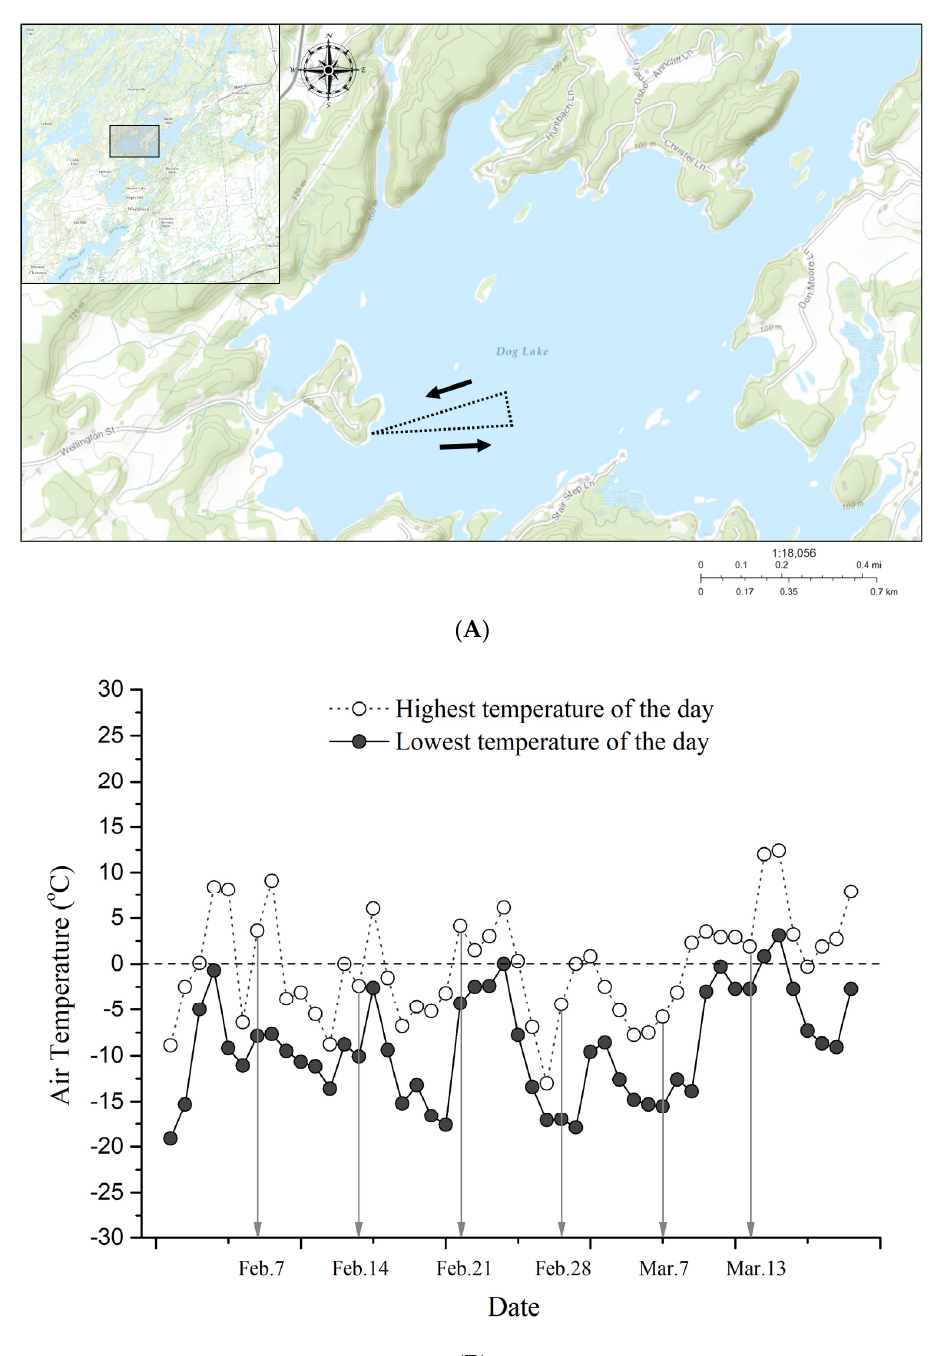
Figure 2. Site sampling information. ( A ) Site map of Gilmour Point, Dog Lake, South Frontenac County, Ontario (44.435635° N, 76.345549° W). Sampling occurred along two transects, with each site roughly equidistant from the origin point with 5–8 samples collected per transect (Supplementary Table S1). ( B ) Ambient temperature at each sampling time. The arrows point at sampling dates. Data were obtained from a Acurite 02064M Pro weather station (Chaney Instrument Co, Lake Geneva, WI, USA) set up in accordance with manufacturer’s specifications at Maple Hill, South Frontenac County, Ontario, Canada (44.398594° N, 76.352457° W).